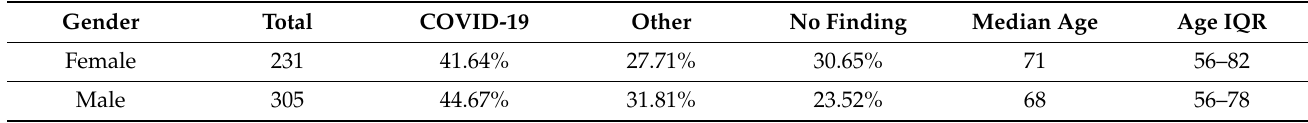
Table 3. Gender statistics of the positive and negative groups.